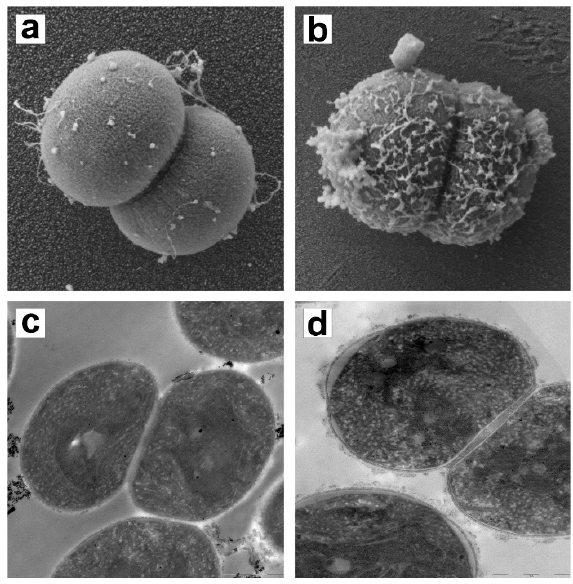
Figure 9. SEM and TEM of M. aeruginosa after C/F treatment. ( a ) SEM M. aeruginosa sp. PCC 7806 control, Mag: 50,000 K; ( b ) SEM M. aeruginosa treated with TMC, Mag: 50,000 K; ( c ) TEM M. aeruginosa sp. PCC 7806 control; ( d ) TEM M. aeruginosa treated with TMC.